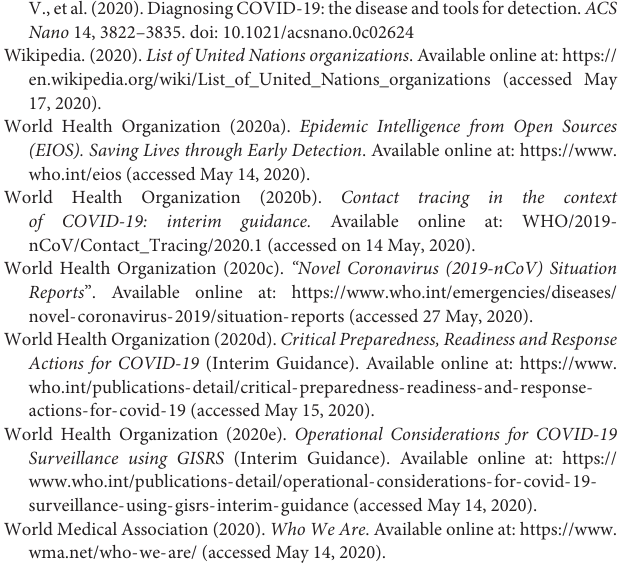
FIGURE 2 | D are transposable nodes of participant countries, UNO, World Medical Association, and Global media and publication. When participant countries are at position-D, they cannot misdemeanor/hide the medical data since every unique case has to be committed to a global ledger. By violating the protocol, they will have to answer to the UN, WHO, and other countries. When UNOs like WHO is at position-D, they cannot have a private dealership with an individual country after bringing this system into existence as every data is transparent and immutable to the whole world. Similarly, when position-D is occupied by news from global media and publication, irrespective of the country and their government, global media will get authenticate and precise information to keep the whole world on the same updated